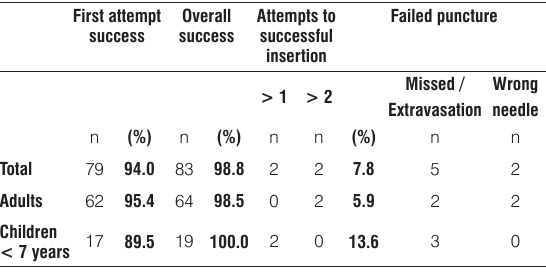
Table 2. Success rates and complications of intraosseous